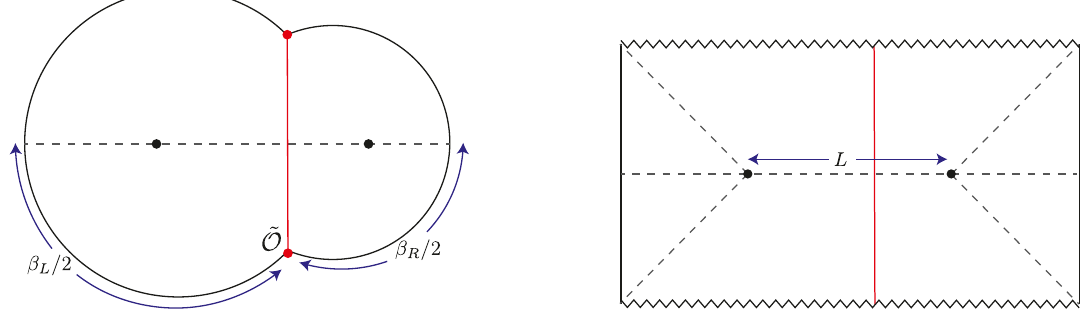
Figure 1 : On the left, the construction of the PETS by a Euclidean path integral, and the dual bulk geometry. The t = 0 slice of the Euclidean geometry provides initial data for the Lorentzian geometry on the